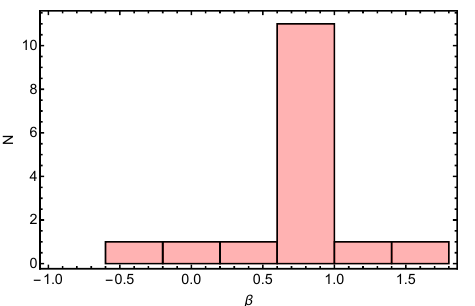
Figure 1. Distribution of spectral indices ( β ) for sample of 18 GRBs that display a plateau in their light